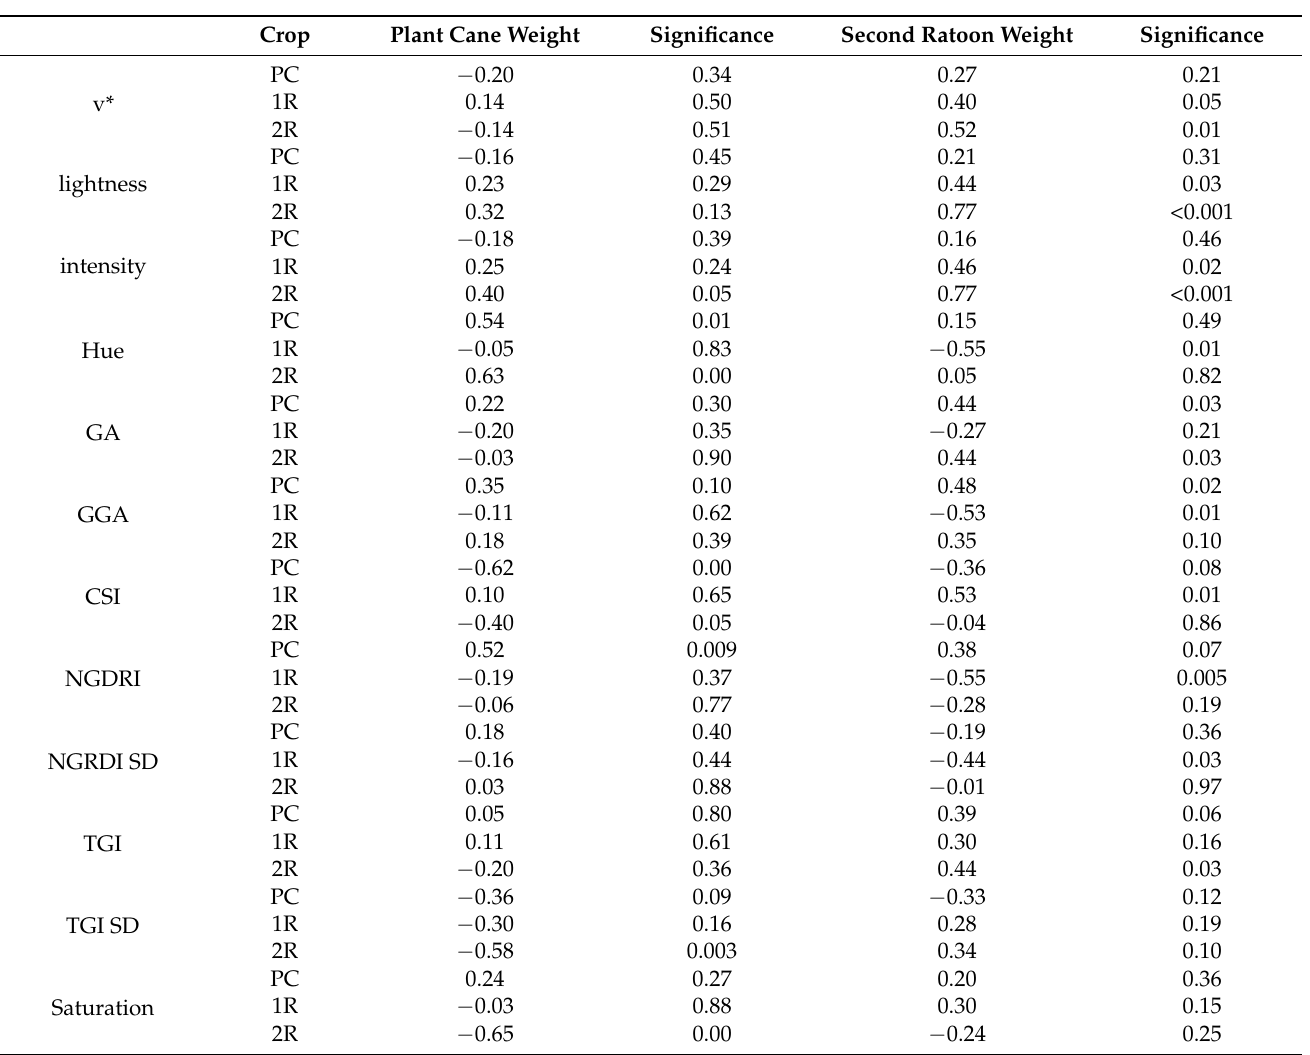
Plant cane (PC) and Second Ratoon (2R) year harvested Plot weight, measurement of cane weight (kg); a*, CIELab color component; b*, CIELab color component; u*, CIELab color component; v*, CIELab color component; Lightness, CIELab color component; Intensity, CIELab color component; Hue, CIELab color component; GA, Green Area; GGA, Greener Area; CSI, Crop Senescence Index; NGRDI, Normalized Green–Red Difference Index; NGRDI SD, NGRDI standard deviation; TGI, Triangular Greenness Index; TGI SD, TGI standard deviation; Saturation, CIELab color